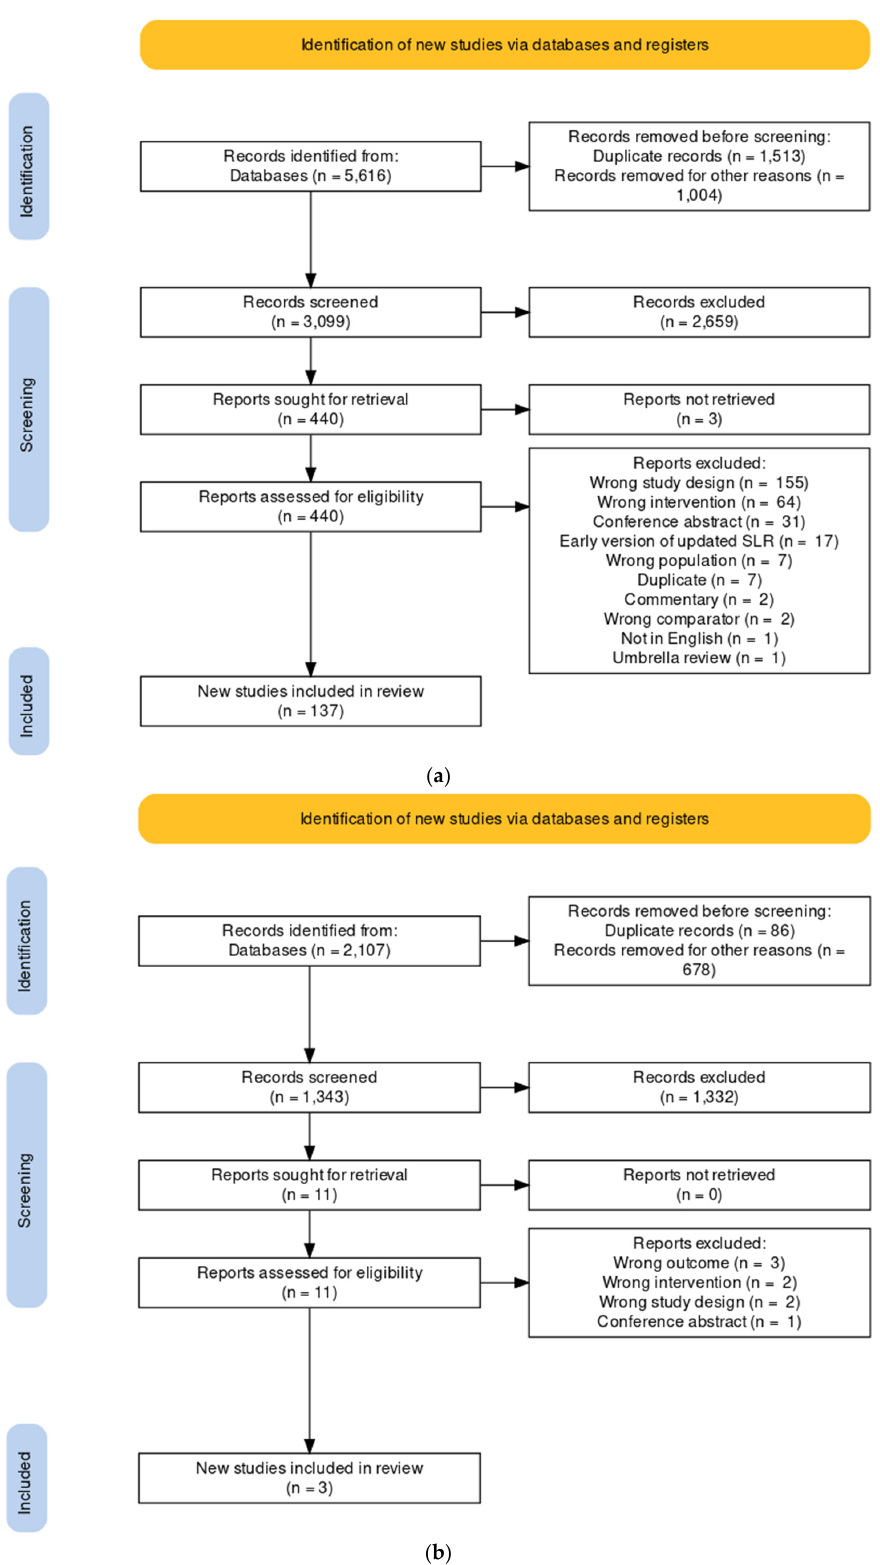
Figure 1. PRISMA flow diagram of the literature search and selection. ( a ) Flow chart for the search for systematic literature reviews with meta-analyses for all color pigments. ( b ) Flow chart for the search for randomized controlled trials and cohort studies for the green pigment chlorophyll.